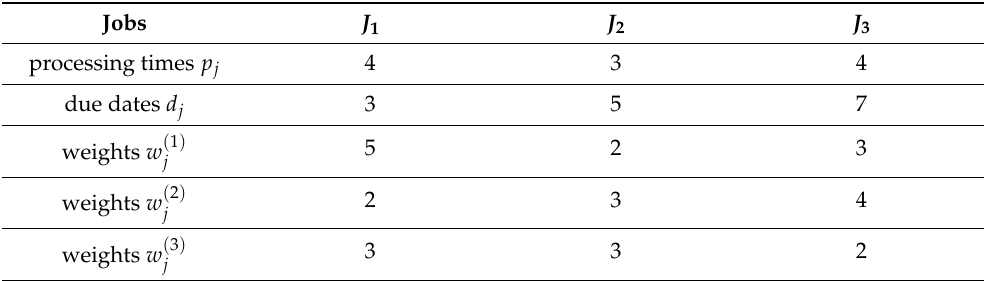
Table 5. Job Instance I 3 for Algorithm DP2.